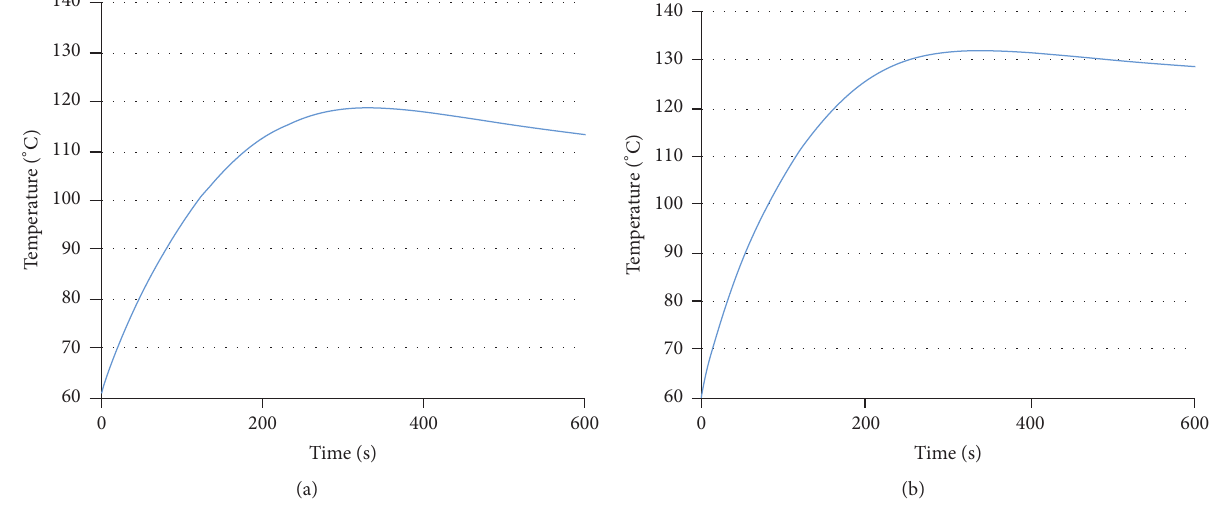
Figure 7: Maximum temperatures of the CNS thermosiphon system for (a) Trip 1 and (b) Trip 2 transients.